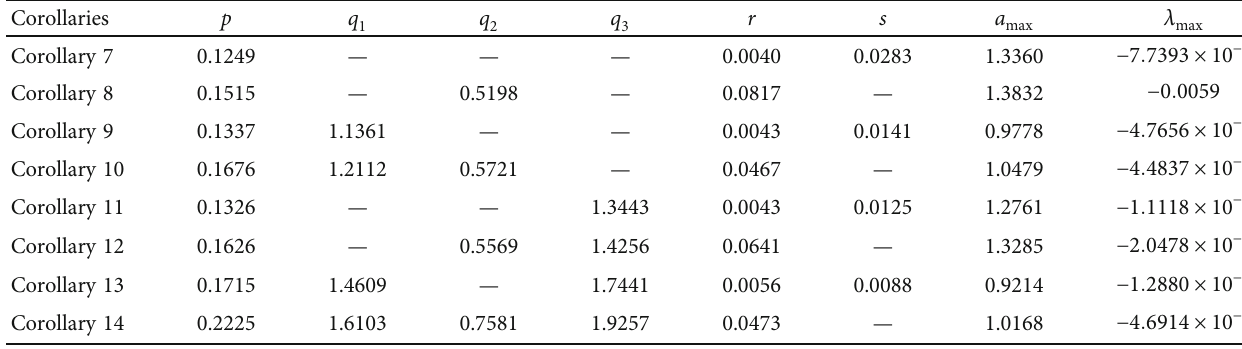
Table 1: Numerical solutions for Example